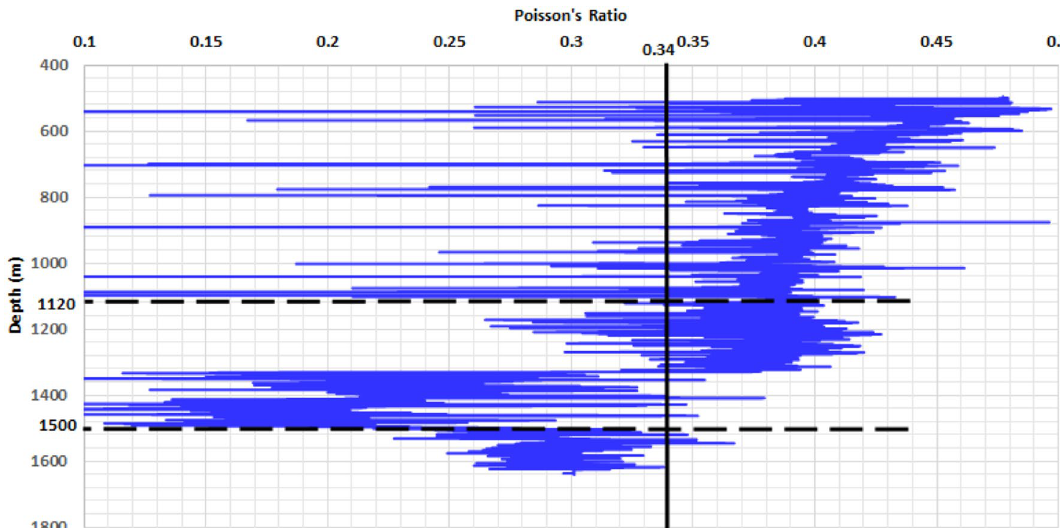
Fig. 16 Poisson’s ratio of Field X